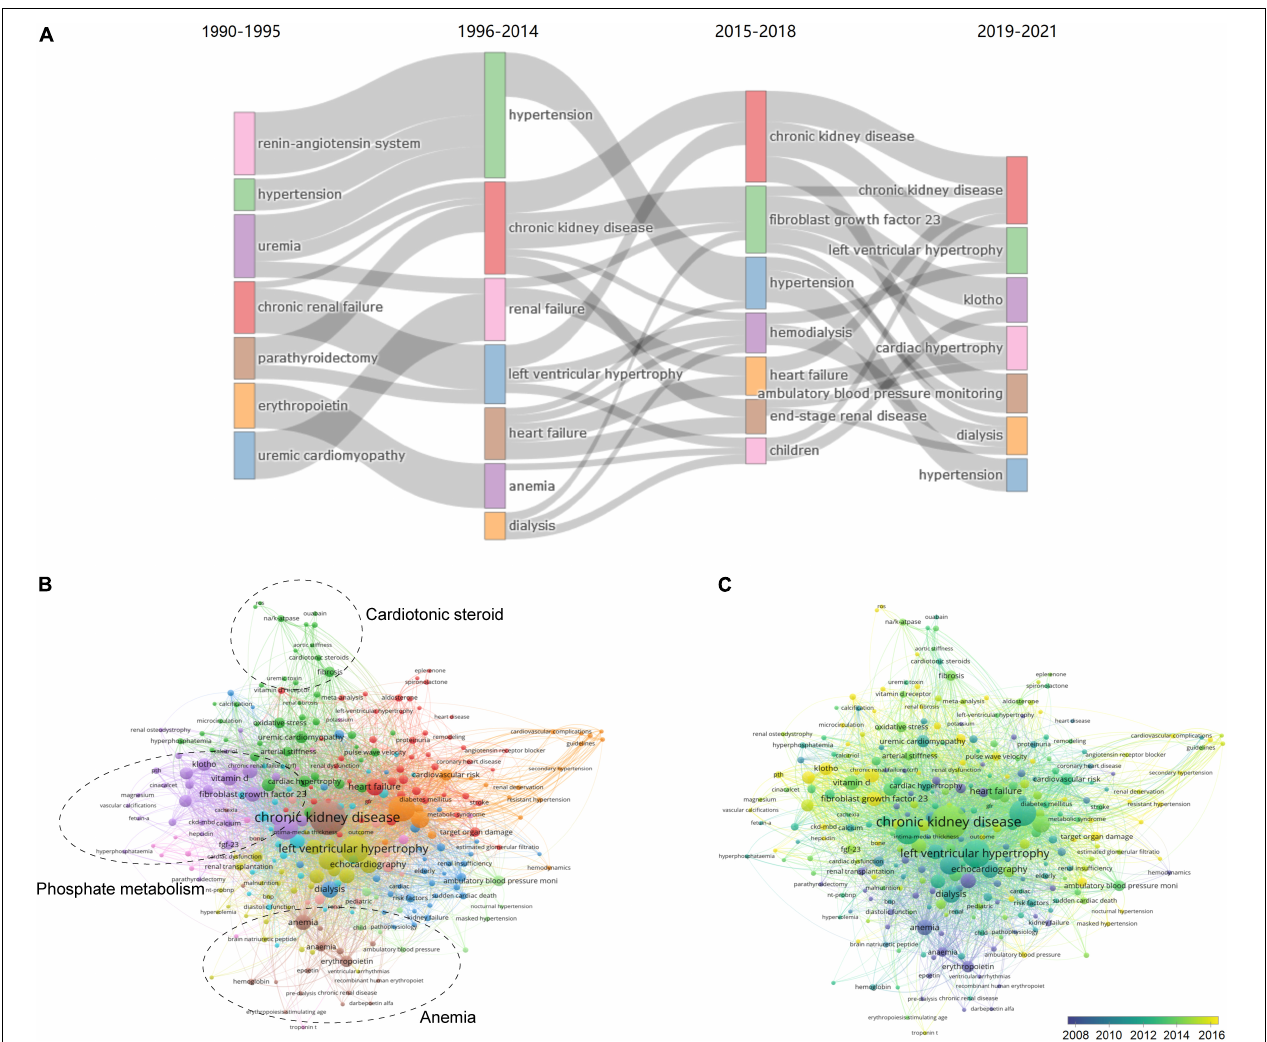
FIGURE 6 | Analysis of keywords in publications and milestones of the uremic cardiomyopathy field. (A) Major keywords evolution of uremic cardiomyopathy research. (B) Clustering of co-occurrence among keywords. (C) Timeline visualization of co-occurrence among keywords.